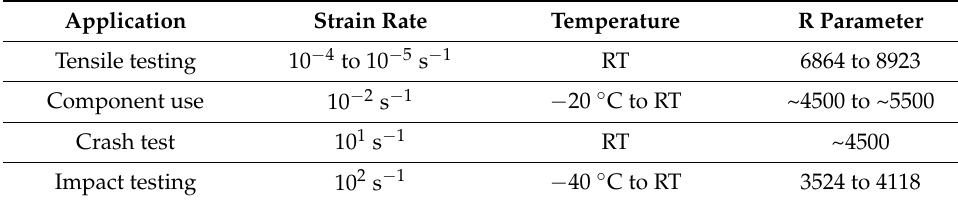
Table 2. Different strain rates and R parameters for components. Adapted from